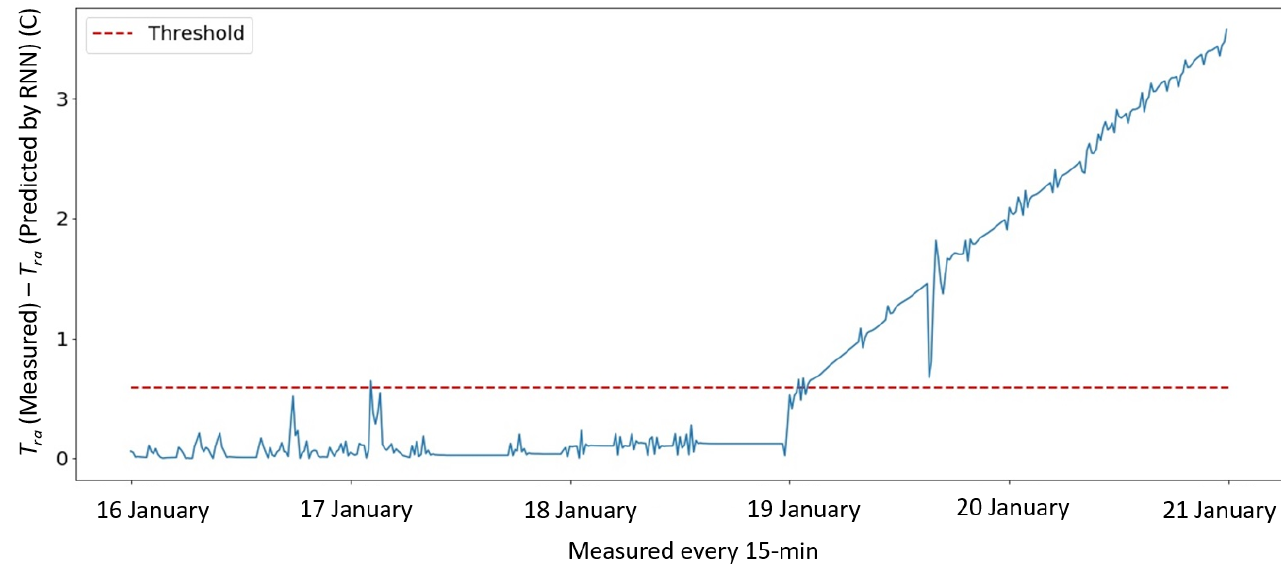
Figure 15 . Residual between measurements and predictions of T ra using RNN model .